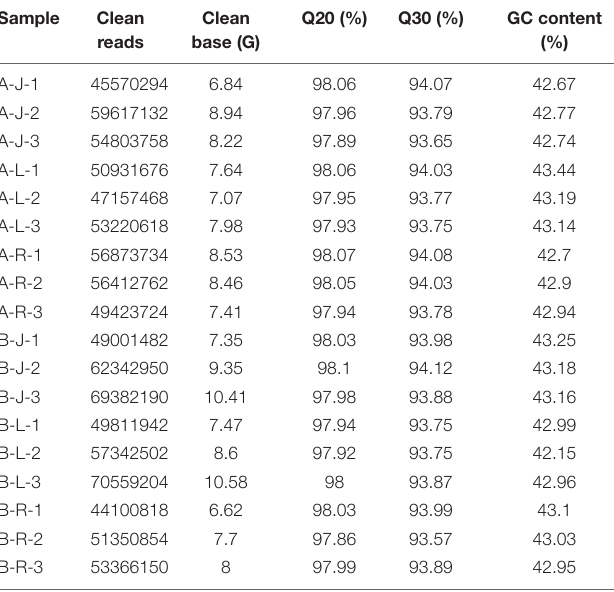
TABLE 1 | Summary of the sequencing data from the 18 P. notoginseng samples.